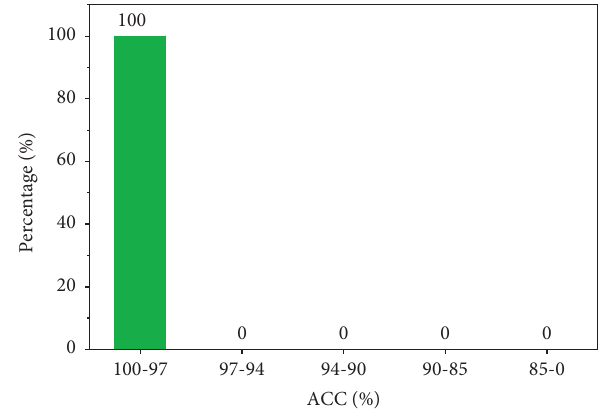
Figure 15: Training accuracy distribution for left turn.